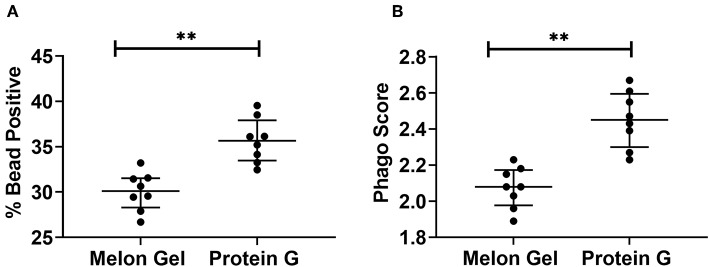
(A) Median + IQR % bead positive THP-1 cells, and (B) phagocytic scores of purified Protein G or Melon Gel IgG from flu vaccinated individuals against hemagglutinin-coated beads. All samples were run in duplicate, and Melon Gel and Protein G responses were compared using the Wilcoxon matched-pair test.